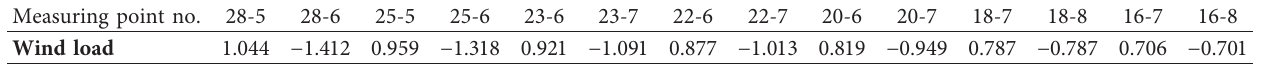
Table 6: Wind loads at junction of plane I and II.